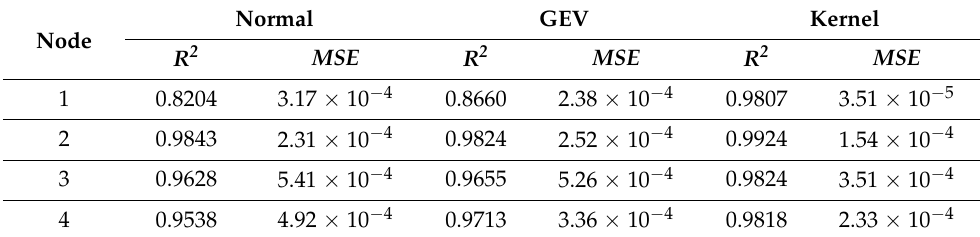
Table 5. Correlation coefficient and mean square error of fitting life of several distributions. Normal GEV Kernel Node R 2